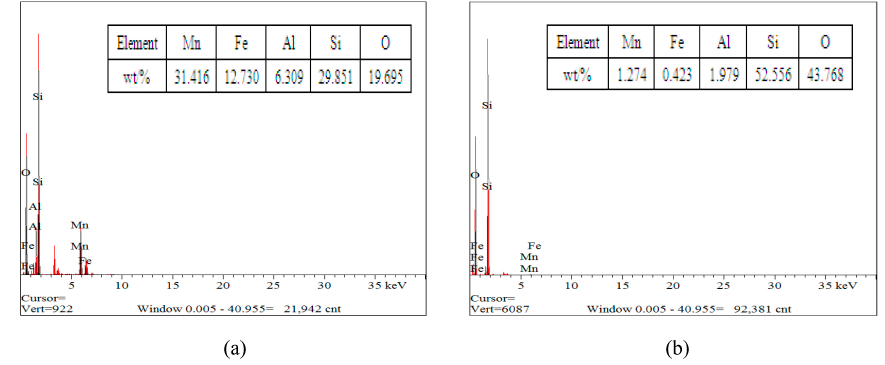
Figure 7. EDS of raw manganese ore or residues under different conditions: ( a ) semi-oxidized manganese ore; and ( b ) leaching residue.